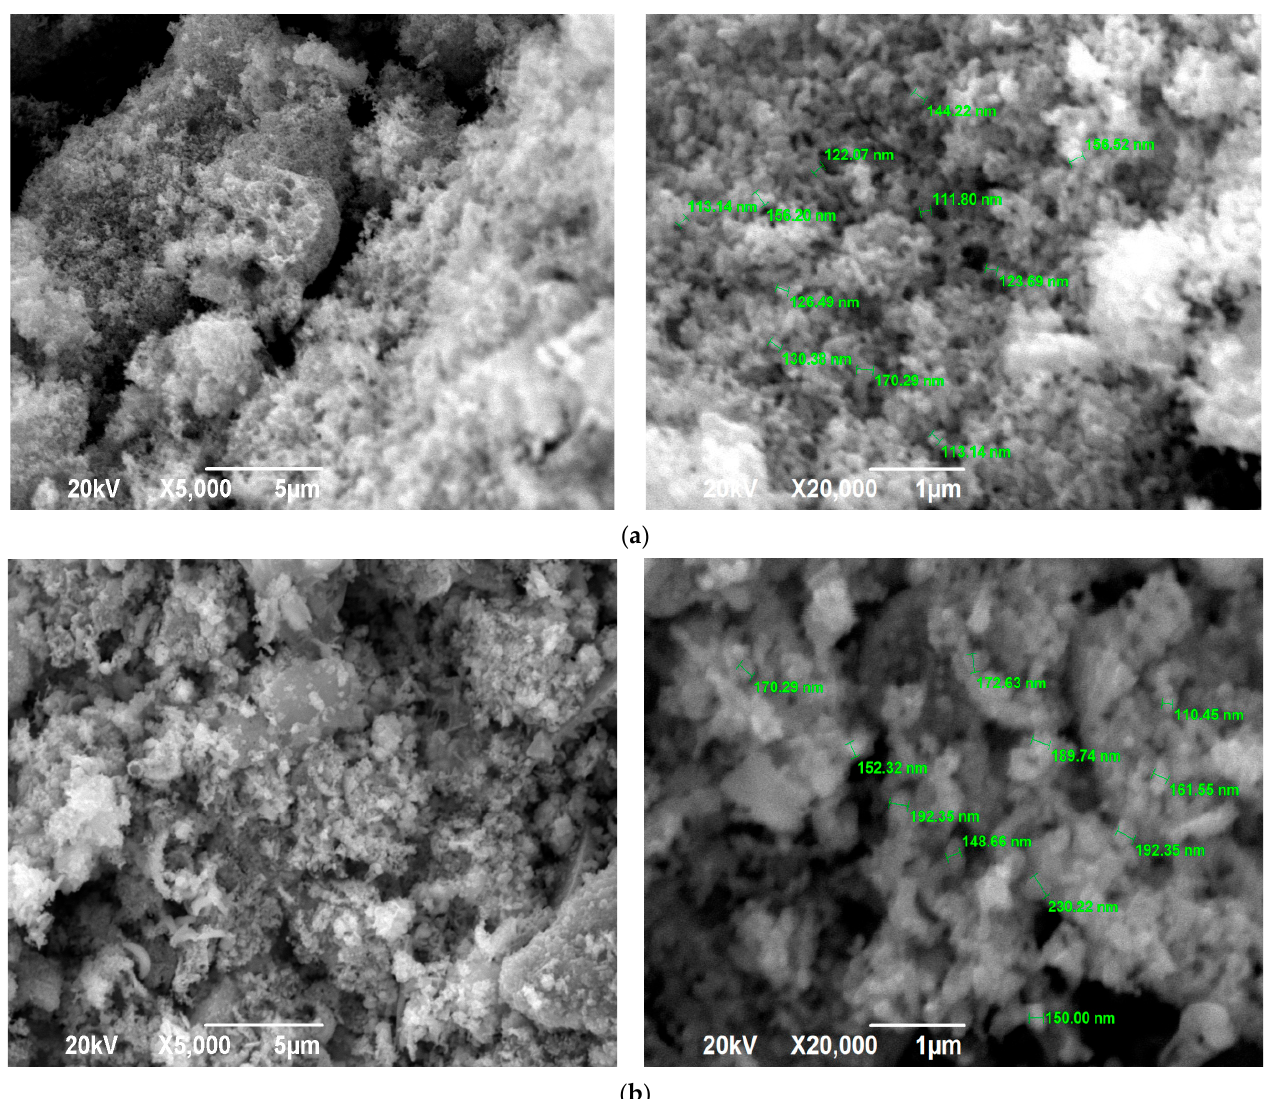
Figure 7. SEM images of the SCS product at various φ after calcination: ( a ) φ = 2; ( b ) φ =